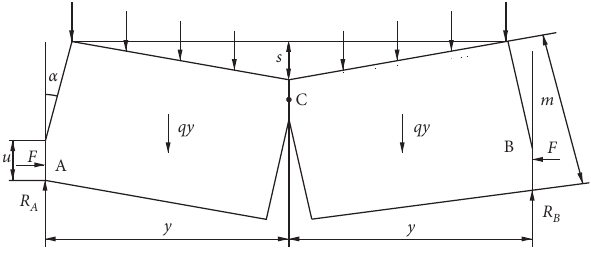
Figure 11: Stress analysis of main roof fault